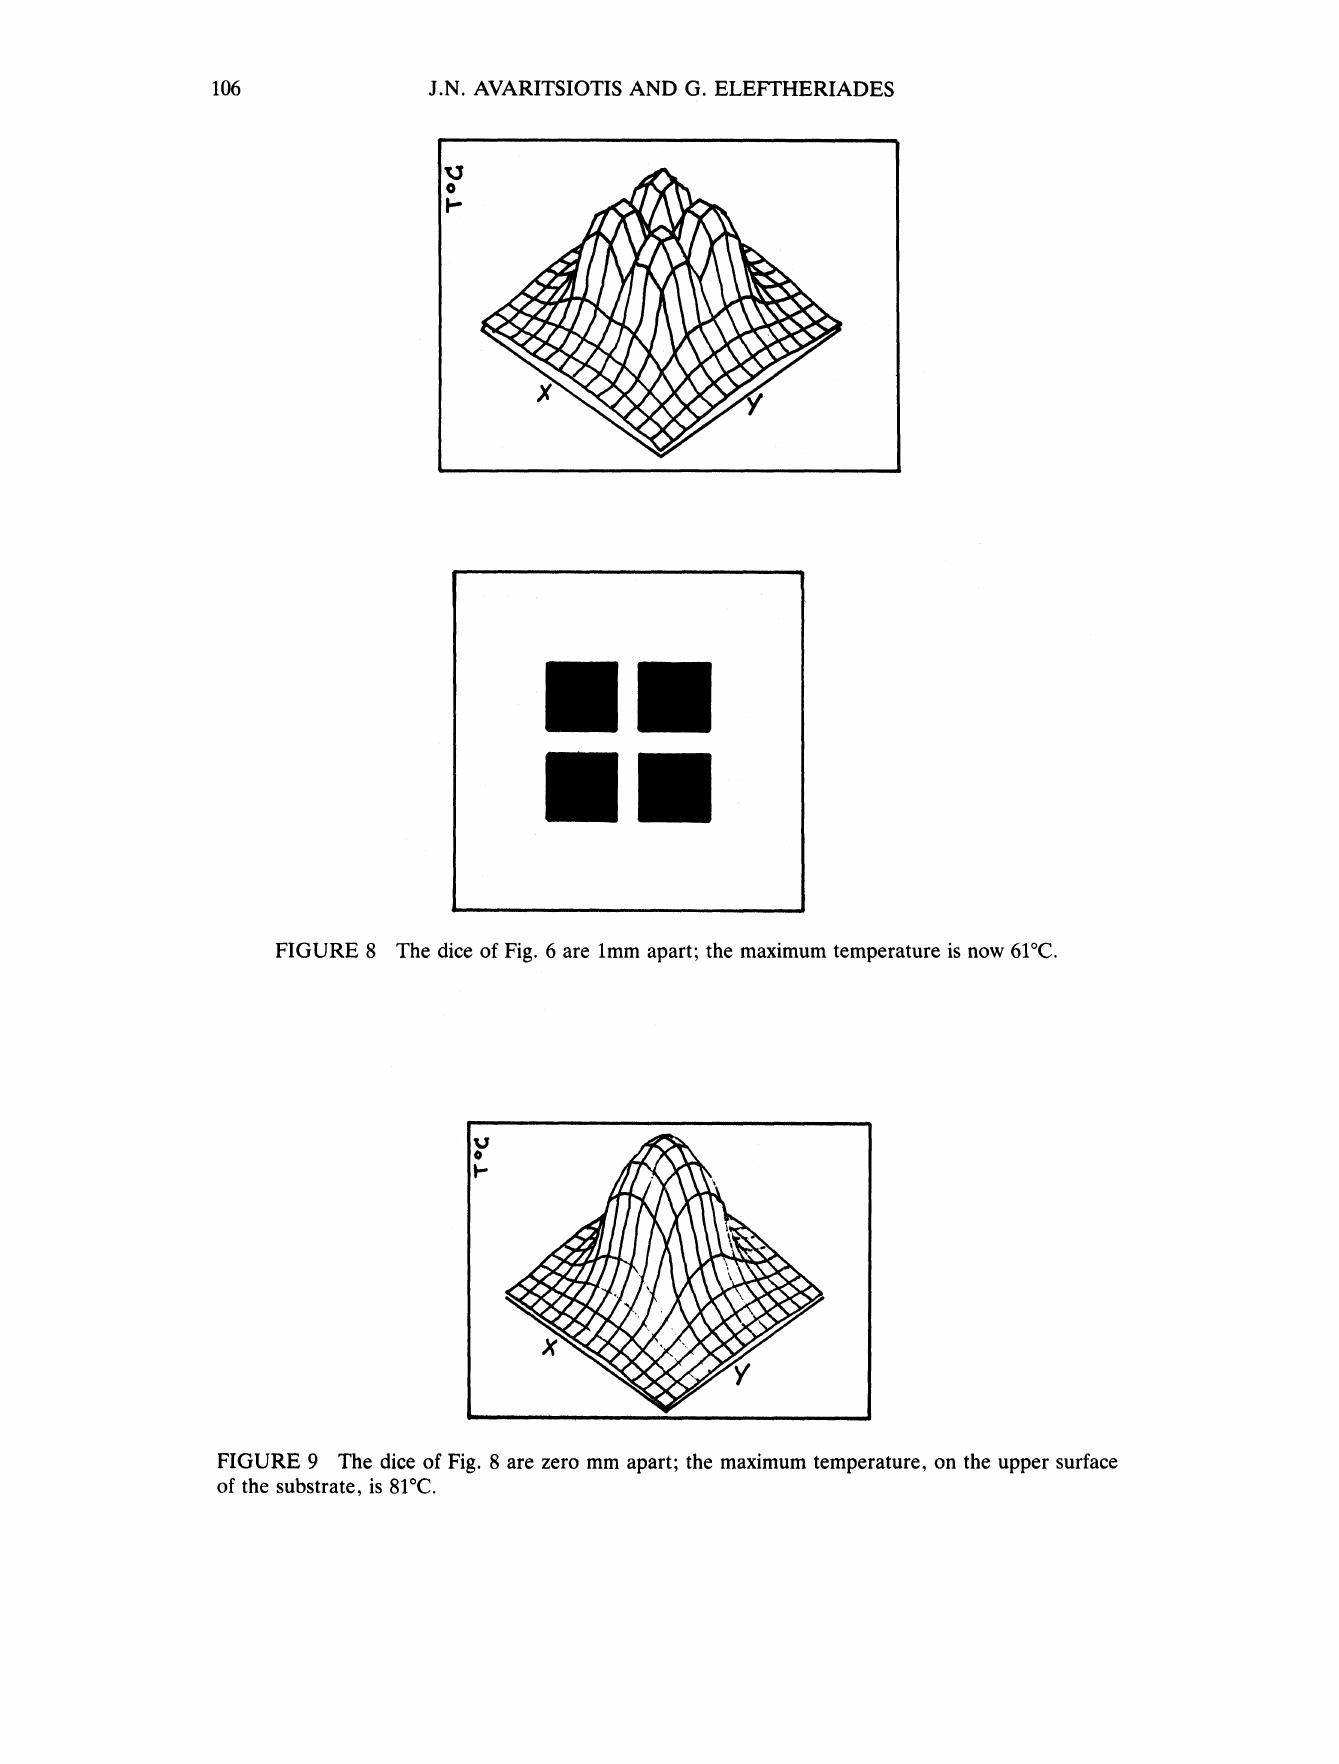
FIGURE 9 The dice of Fig. 8 are zero mm apart; the maximum temperature, on the upper surface of the substrate, is